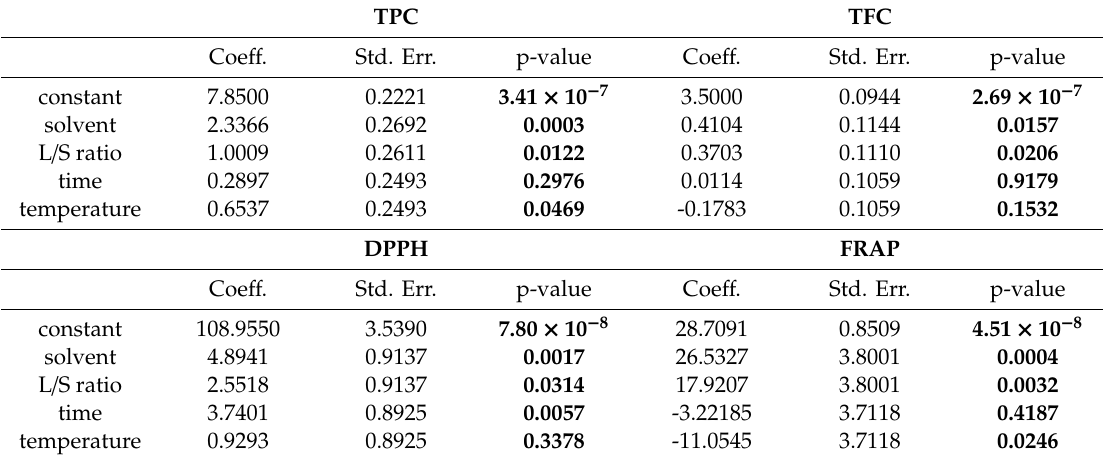
Table 5. Model coe ffi cients (Coe ff .), standard error (Std. Err.) and p-values for the considered responses.